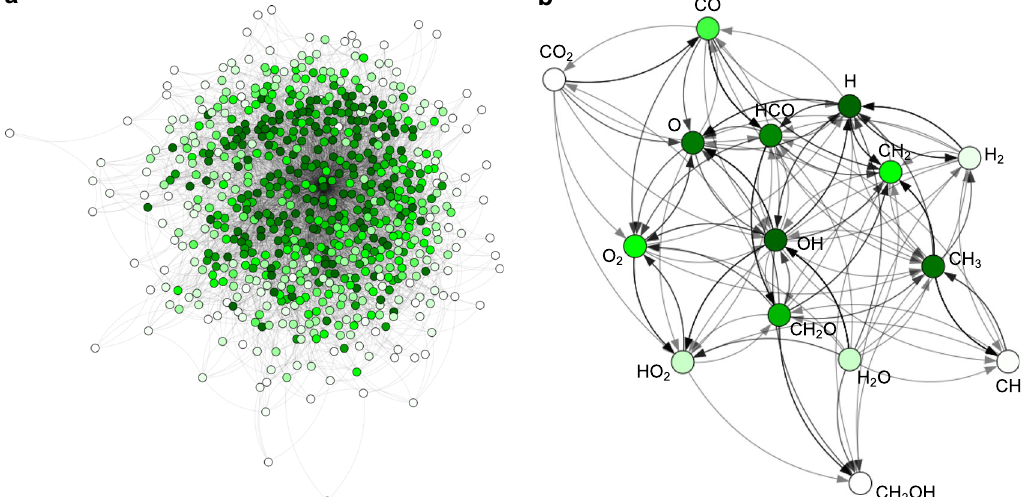
Fig. 1 Visualization of chemical reaction spaces as graphs with molecules as nodes and reactions as edges. a Full network of bond dissociation reactions for carbon-, oxygen-, hydrogen-containing molecules with up to four heavy atoms. b Reduced reaction network of the initial steps of natural gas combustion. Nodes are colored according to the number of incident edges/reactions (their degree) from low (white) to high (dark